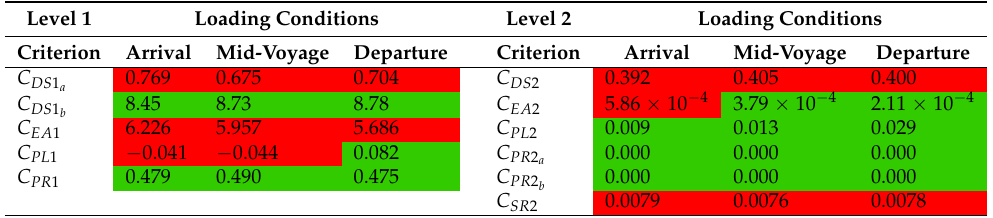
Figure 3. Diagram of the variation in transverse metacentric height in waves for each unit. The wave steepness, s w , is equal to 0.0334 and the wavelength is equal to the ship length. Table 4. Comprehensive assessment of SGISc vulnerability levels for Y02. Criteria compliant with the standard are highlighted in green. Criteria not compliant with the standard are highlighted in red.